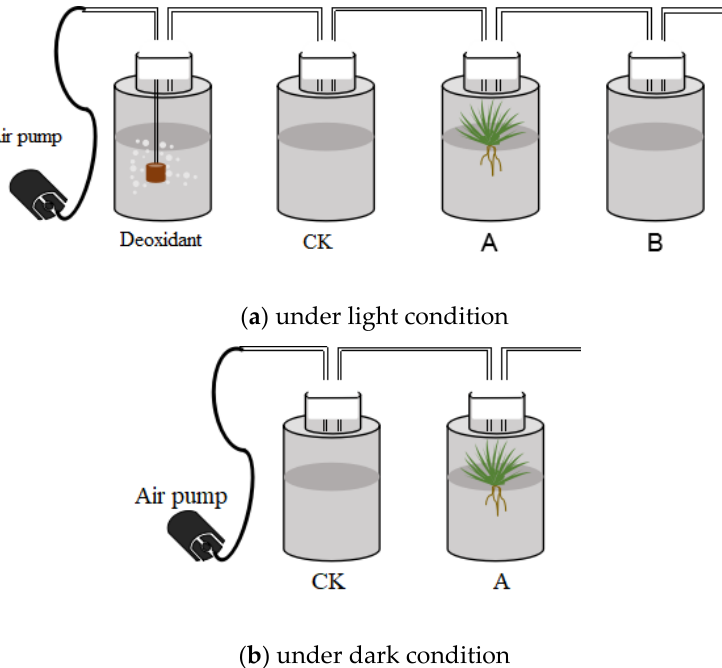
Figure 2. Diagram of Acorus gramineus Aiton root oxygenation.